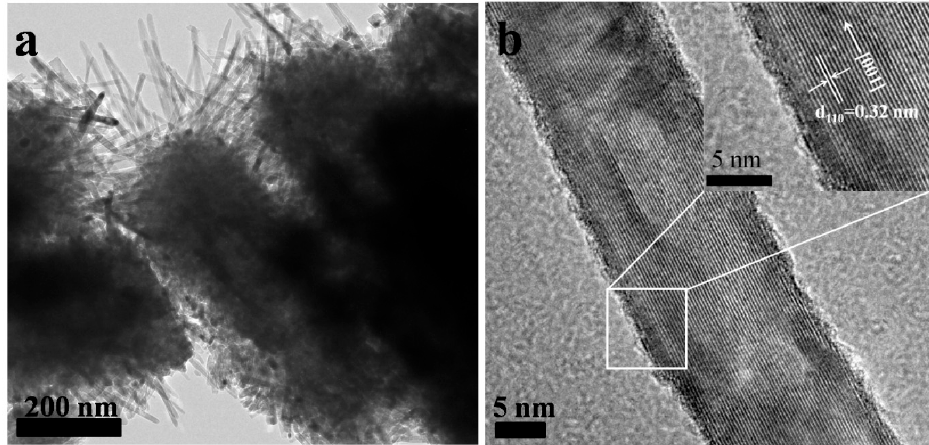
Figure 3. Overlapping of TEM and HRTEM images of ( a ) branched TiO 2 NRAs and ( b ) a single branch.